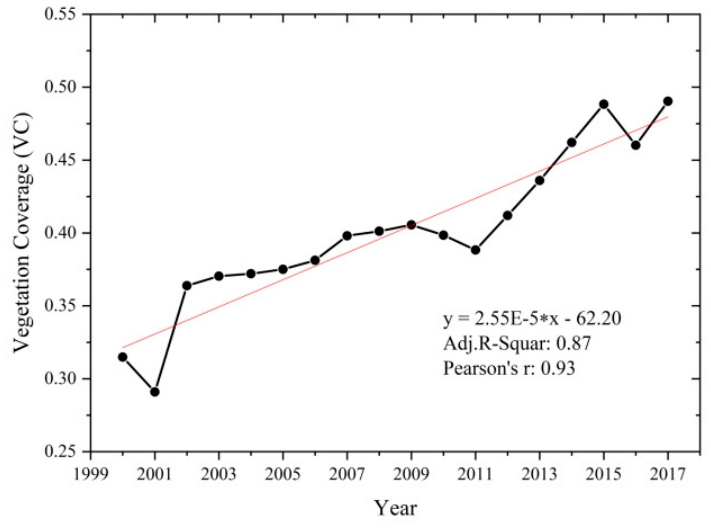
Figure 6. Mean change in VC in the HJN watershed in 2000–2017. The dotted line represents the yearly mean values of VC and the red line is its linear trend fitting line.